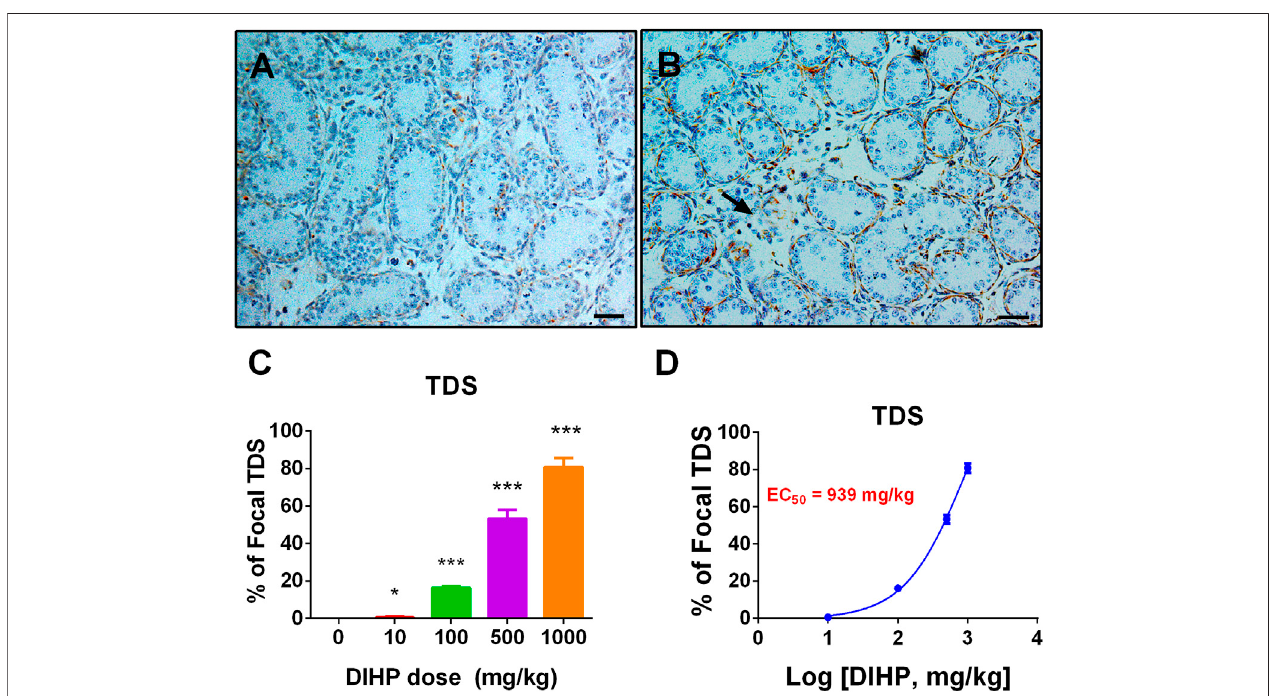
FIGURE 7 | Effect of DIHP exposure on focal testicular hypoplasia. From GD 12 to GD21, 0 (control), 10, 100, 500, and 1,000 mg/kg DIHP were administered by gavage to dams. Panels (A, B) : Immunohistochemical staining of DIHP at 0 and 1,000 mg/kg. Arrows indicate areas of focal hypoplasia; Scale bar (cid:1) 50 microns; (C) quantitative results; (D) IC 50 value. Data are expressed as mean ± SEM, n (cid:1) 6; * p > 0.05, *** p < 0.01 indicate that the signi fi cant level between the DIHP group and the control group, respectively.